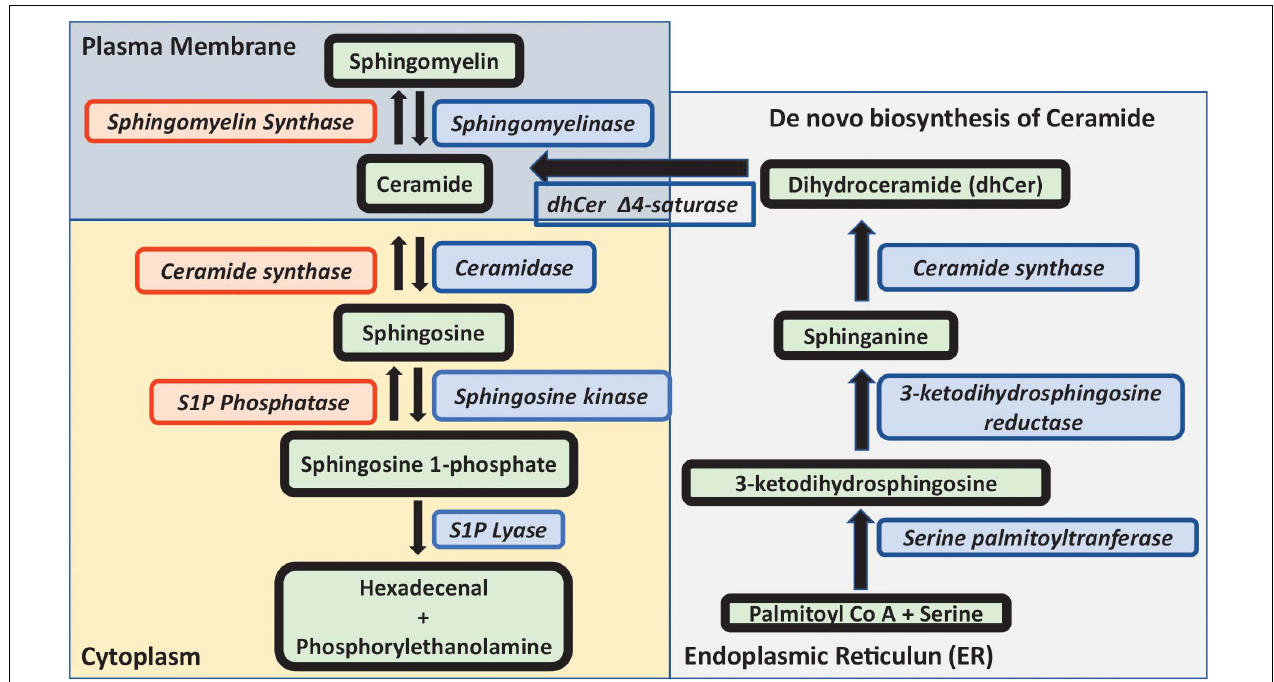
FIGURE 1 | Metabolism of sphingolipids. Outline of sphingolipid metabolism. The de novo biosynthesis of ceramide is initiated by the condensation of serine and palmitoyl-Co A to 3-ketodihydrosphingosine, which is reduced to sphinganine, and the addition of an acyl fatty acid to sphinganine forms dihydroceramide which is desaturated to ceramide in the ER. Ceramide is either converted to sphingomyelin in the presence of sphingomyelin synthase or to sphingosine by the action of ceramidase. Sphingosine kinase converts sphingosine to sphingosine 1-phosphate which is either degraded by sphingosine lyase or subsequently converted back to ceramide and sphingomyelin. In this review, sphingosine, ceramide and sphingosine 1-phosphate in relationship to SARS-CoV-2 are discussed in more